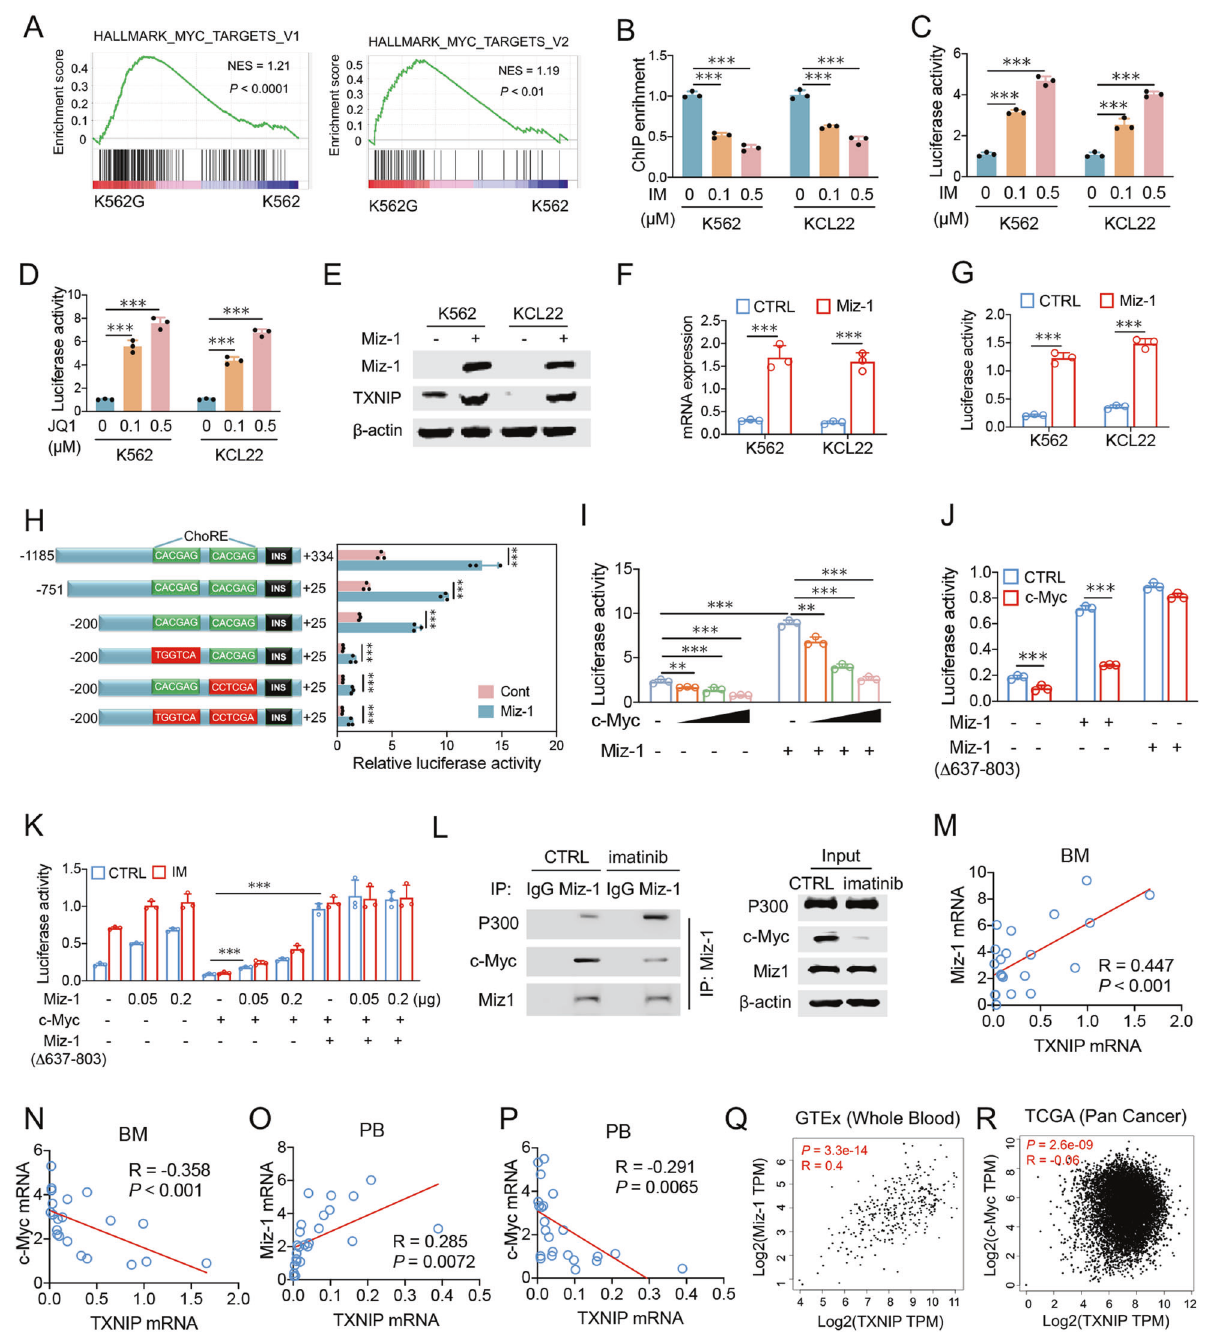
Fig. 2 BCR-ABL blocks TXNIP transactivation by disrupting a Miz-1 – p300 complex via c-Myc induction. A GSEA analysis of the RNAseq data predicts the gene enrichment in c-Myc targets in K562G and K562 cells. B The amount of c-Myc bound to the TXNIP promoter was determined by ChIP in K562 and KCL22 cells 24 h after imatinib treatment. C , D The activity of TXNIP promoter ( − 1185 ~ + 334) was determined in K562 and KCL22 cells 24 h after imatinib ( C ) or JQ1 ( C ) treatment. E – G TXNIP protein ( E ), mRNA ( F ), and promoter activity ( G ) were determined, respectively, in K562 and KCL22 cells 48 h after the transfection of Miz-1 overexpression vector. H The indicated TXNIP promoter truncations were transfected into K562 cells with or without Miz-1 overexpression. The luciferase activity were determined. I K562 cells were transfected with the TXNIP reporter construct ( − 751 ~ + 25) with or without a c-Myc expression plasmid. Increasing amounts (0.02, 0.1, and 0.2 μ g) of Miz-1 construct were co-transfected as indicated. J K562 cells were transfected with the TXNIP reporter construct ( − 751 ~ + 25) together with wild-type Miz-1 and its mutant construct, as indicated. K K562 cells were transfected with indicated constructs with TXNIP reporter truncation ( − 751 ~ + 25). 24 h after transfection, cell were treated with 0.5 μ M imatinib for additional 24 h. L K562 cells were transfected with Miz-1 constructs and treated with 0.5 μ M imatinib. Immunoprecipitation was performed with Miz-1 antibody. Indicated proteins were further determined by western blot. M – P The mRNA expression associations of TXNIP with Miz-1 or c-Myc in the PB and BM were determined among samples from normal healthy donors and patients. Each individual dot represents 1 sample. Q The mRNA expression associations of TXNIP with Miz-1 were analyzed by GEPIA according to the whole blood samples from normal human in GETx dataset. R The mRNA expression associations of TXNIP with c-Myc were analyzed by GEPIA according to the Pan-Cancer samples from normal human in TCGA dataset. B , C , K , L IM, imatinib. *** P < 0.001. ** P <